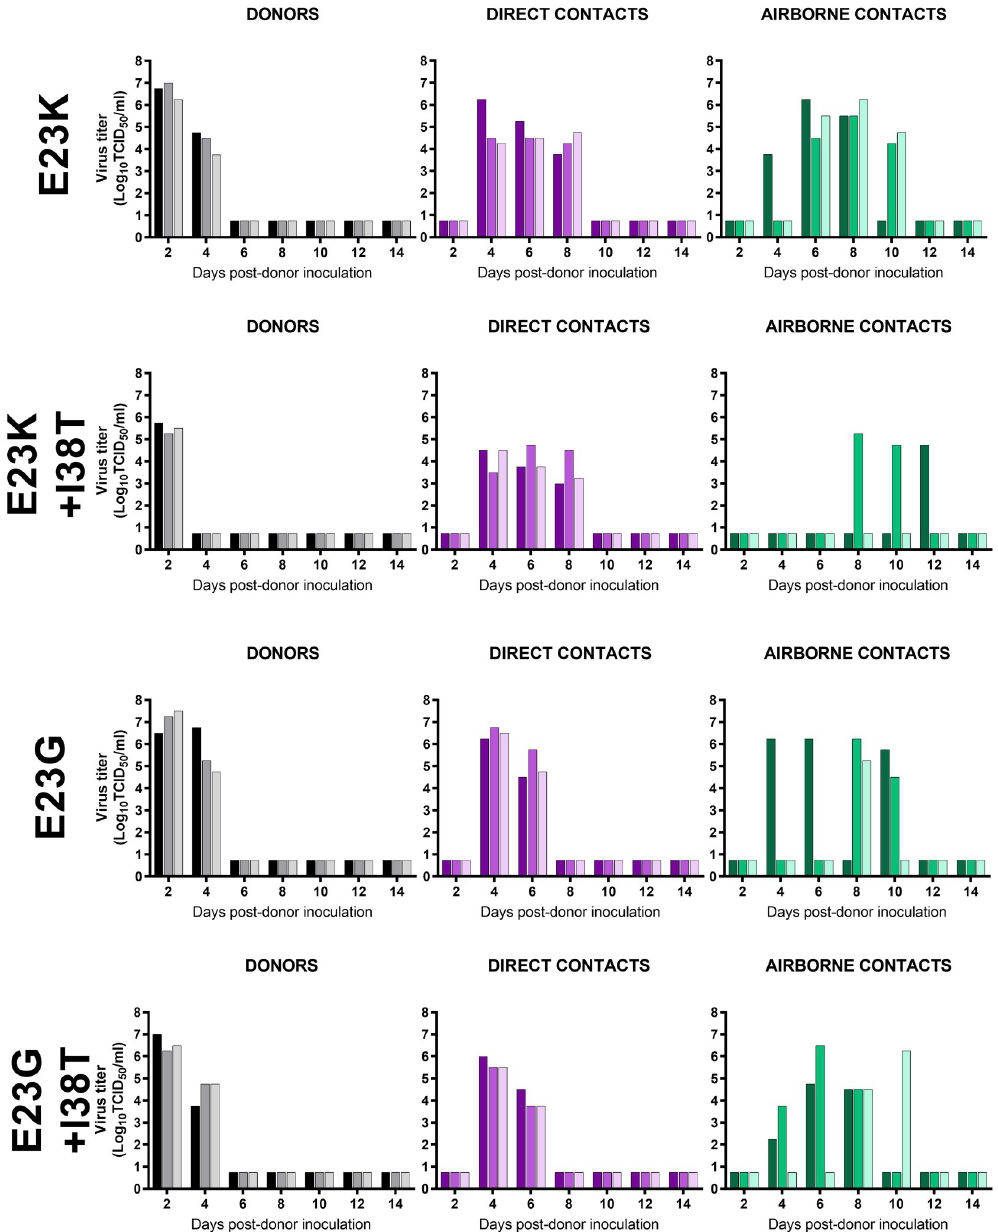
Fig 2. Transmissibility of PA E23G/K influenza A viruses in ferrets. Donor ferrets (n = 3, black/gray) were inoculated intranasally with the indicated PA-substituted virus. Twenty-four hours later, direct contact animals (n = 3, shades of purple, each in the same cage as the respective donor) and airborne contact animals (n = 3, shades of green, in an adjacent cage with an air-permeable barrier that excluded physical contact) were introduced. Virus titers (in Log 10 TCID 50 /mL; limit of detection: 0.75 Log 10 TCID 50 /mL) were determined in nasal washes collected at the indicated timepoints and titrated in MDCK cells. Color-matched bars represent the virus shed by an individual animal over